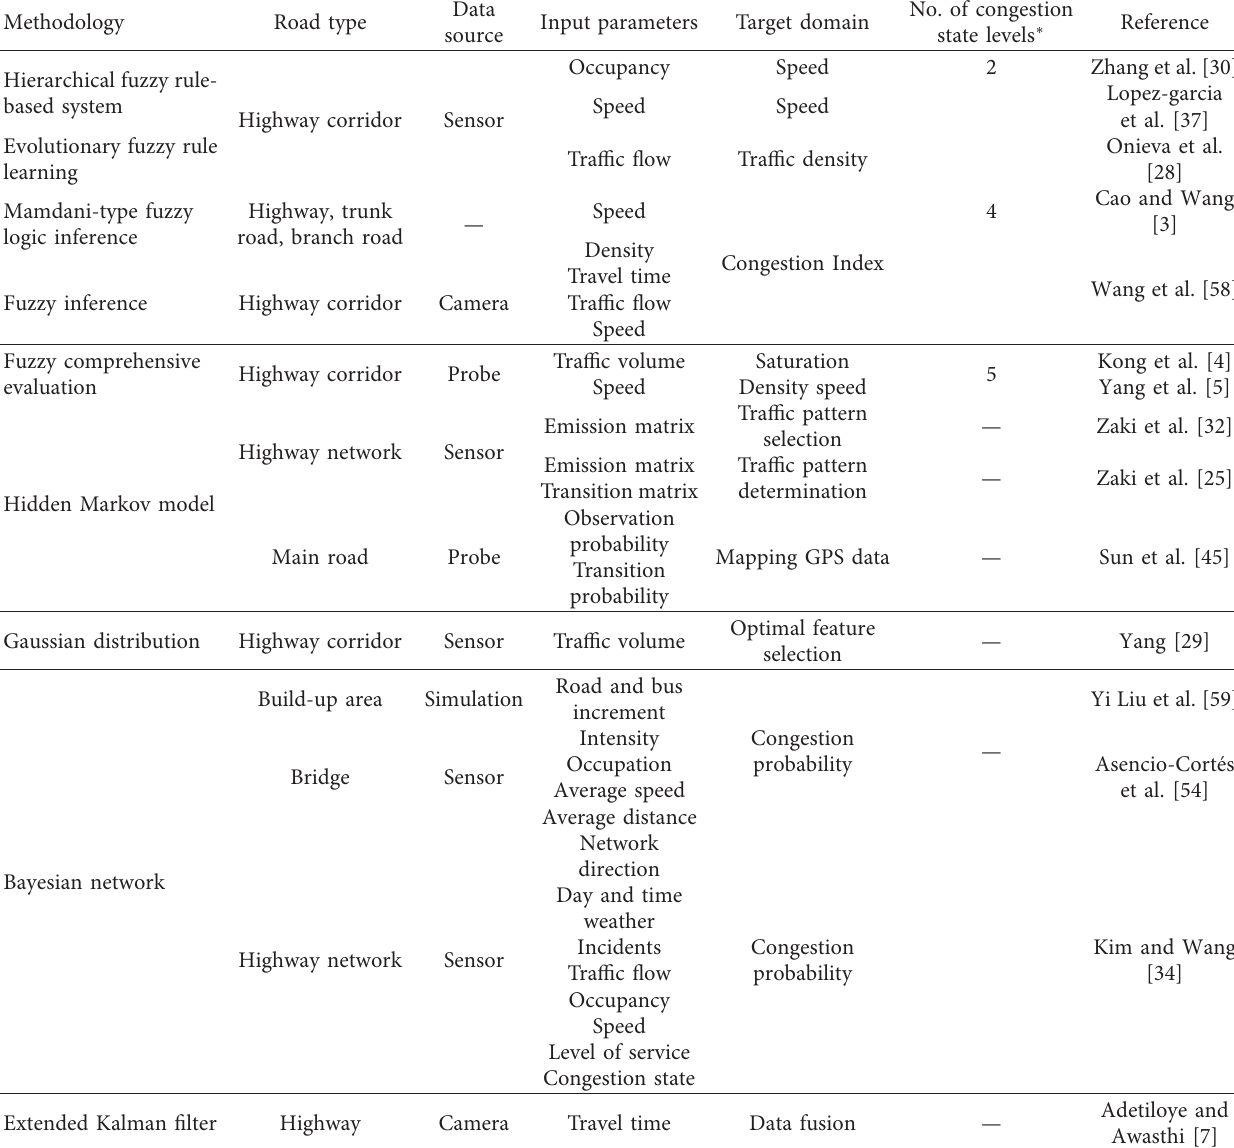
Table 1: Traffic congestion prediction studies in probabilistic